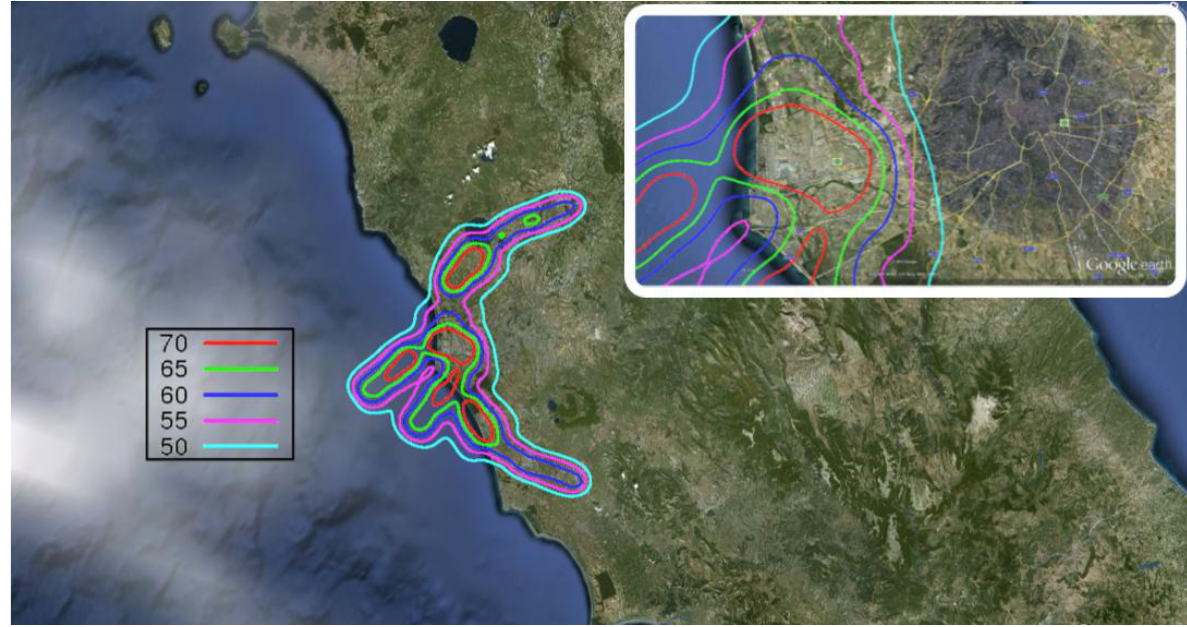
Figure 6: SEL contour levels for a complete sequence of optimized arrival and departures operated at Rome international airport using α = β = 0.5 .